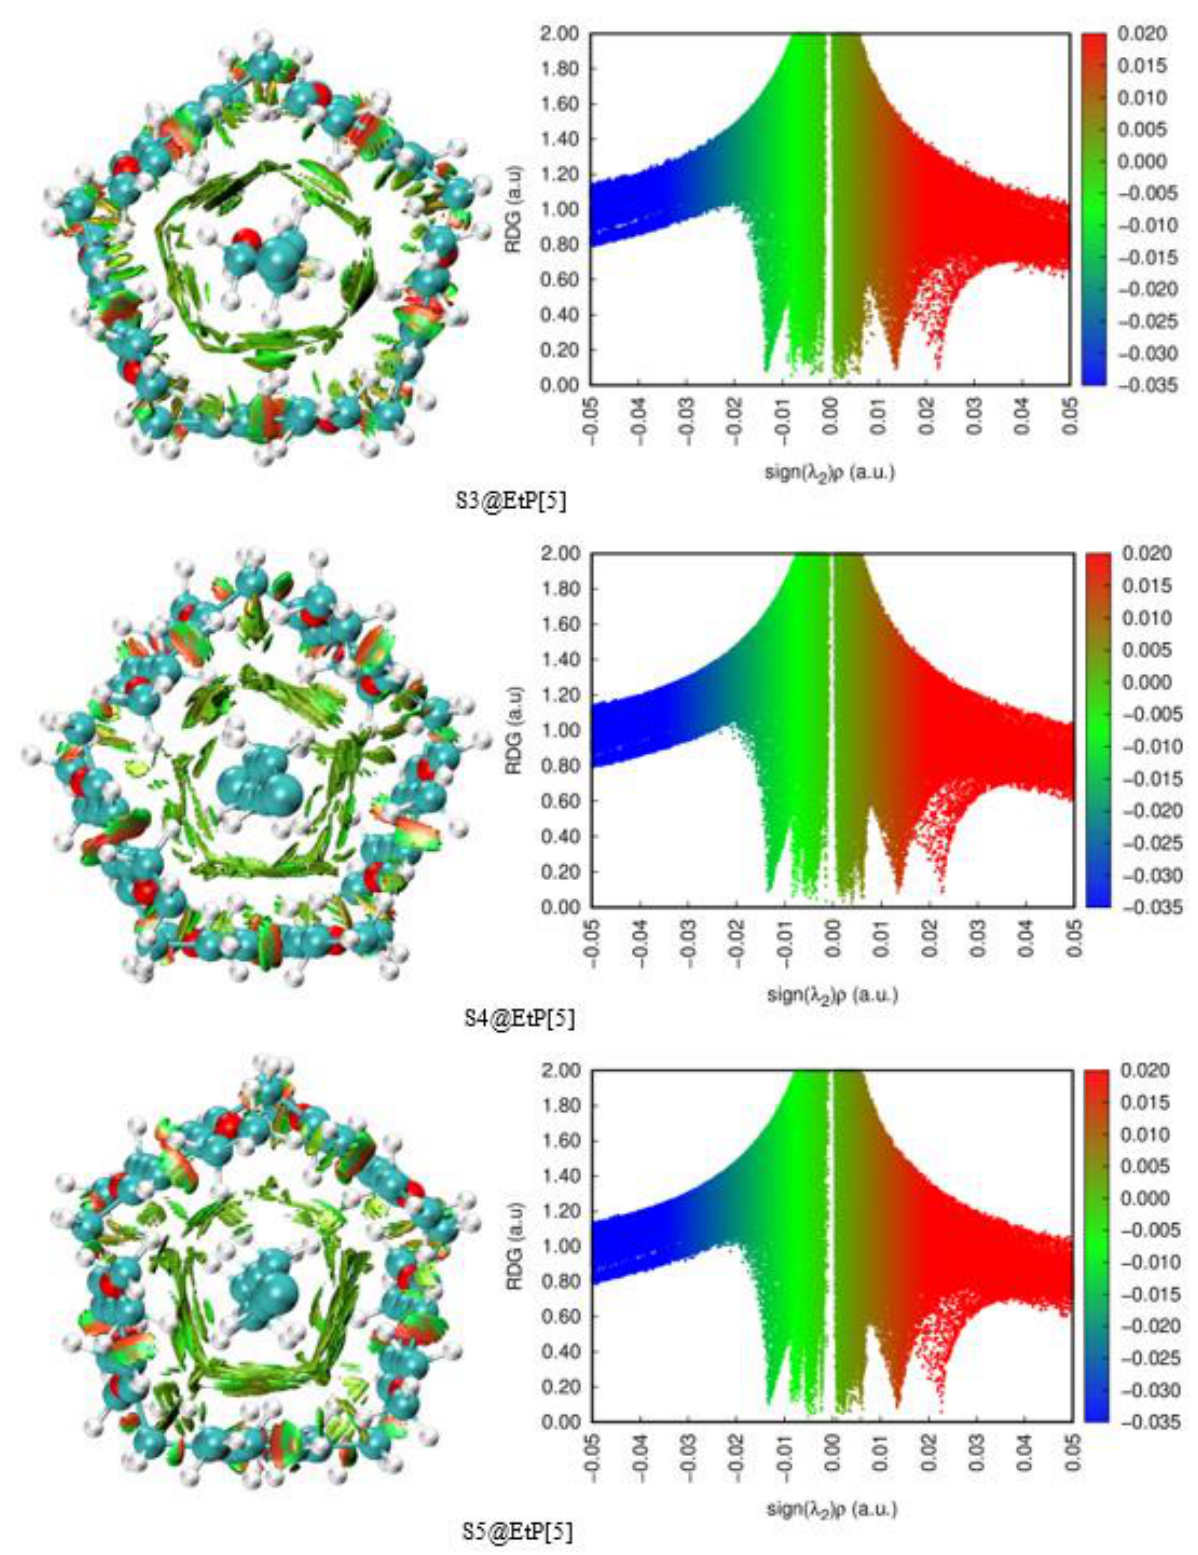
Figure 2. NCI-RDG isosurfaces (isovalue 0.5 a.u.) ( left ) and scatter plots ( right ) of SM@EtP[5], S1@EtP[5], S2@EtP[5], S3@EtP[5], S4@EtP[5], and S5@EtP[5].